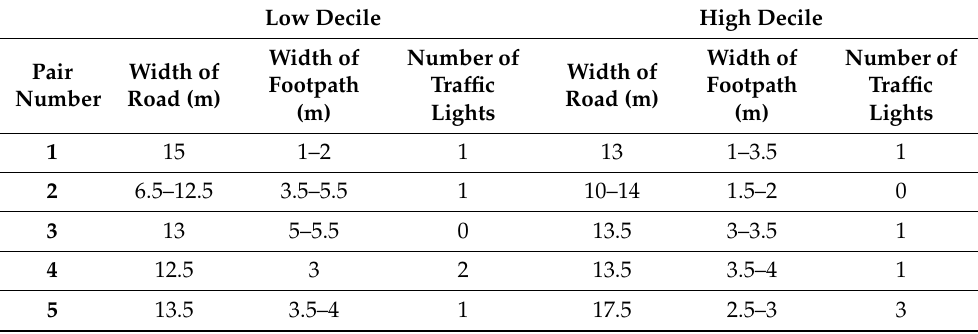
Table 2. The characteristics of the routes (the width of footpath and road are measured in the main